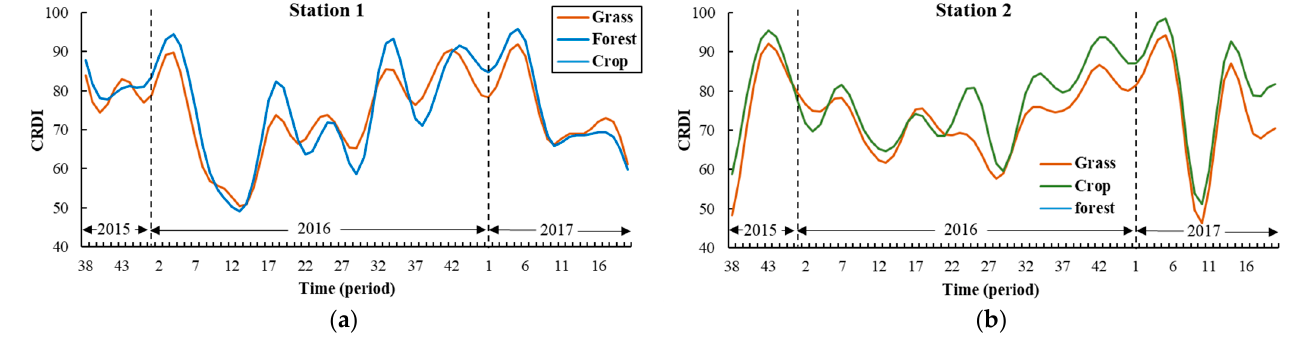
Figure 6. The indexes of different vegetation types in the same geographical location. Station 1 ( a ) was used to compare the difference between forest and grass, and station 2 ( b ) was used to compare the difference between agriculture and grass. The dotted line represents the division of years.